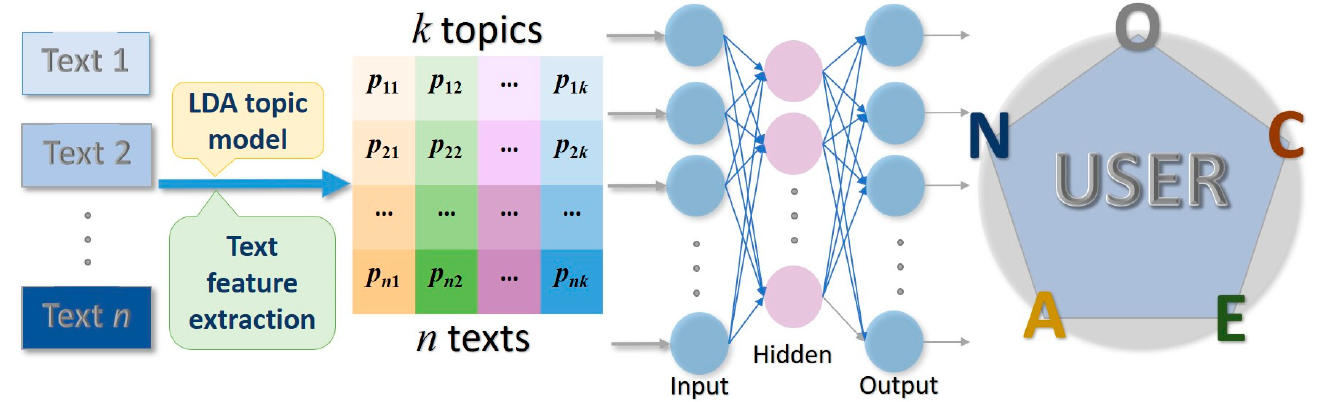
Figure 4. OCEAN (Openness, Conscientiousness, Extraversion, Agreeableness, and Neuroticism) personality model identification structure.